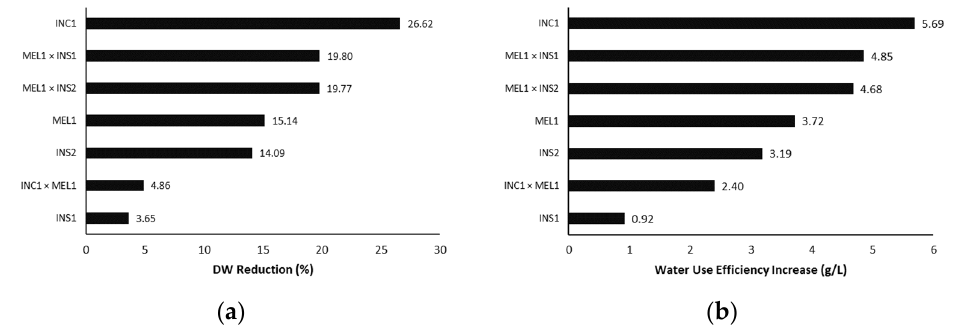
Figure 5. Percent reduction in dry biomass of total plant weight ( a ) and increase in water use effi- ciency (g/L) ( b ) in the water-stressed plants compared to their respective controls. The increase in water use efficiency was calculated as the increase in grams of dry biomass produced from t0 per litre of water